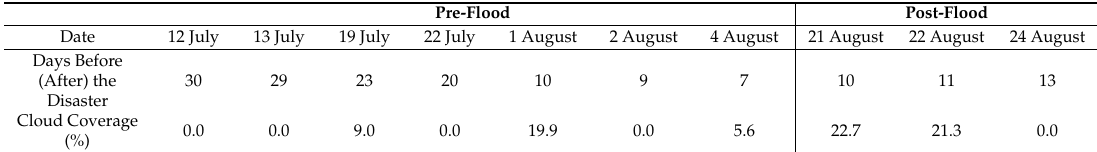
Table 9. The dates and cloud coverages of pre- and post-flood DNB images of the Louisiana Flood.